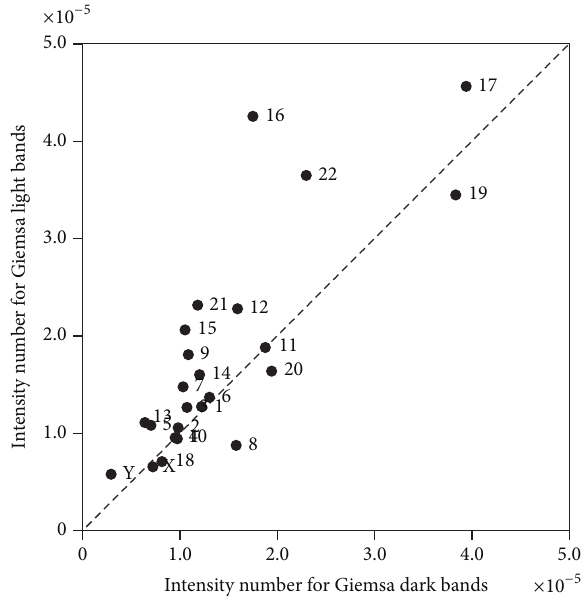
Figure 1: Integration of HIV-1 isolated from Jurkat T cells in Giemsa dark bands versus Giemsa light bands. Graphical representation of the results for the intensity number. Each point represents a chromosome whose coordinates are the (𝑥,𝑦) pairs obtained in the measure calculations. The statistical analysis indicates that the virus integrates preferentially in Giemsa light bands (Wilcoxon test, 𝑇 obs : 59; 𝑇 critic :